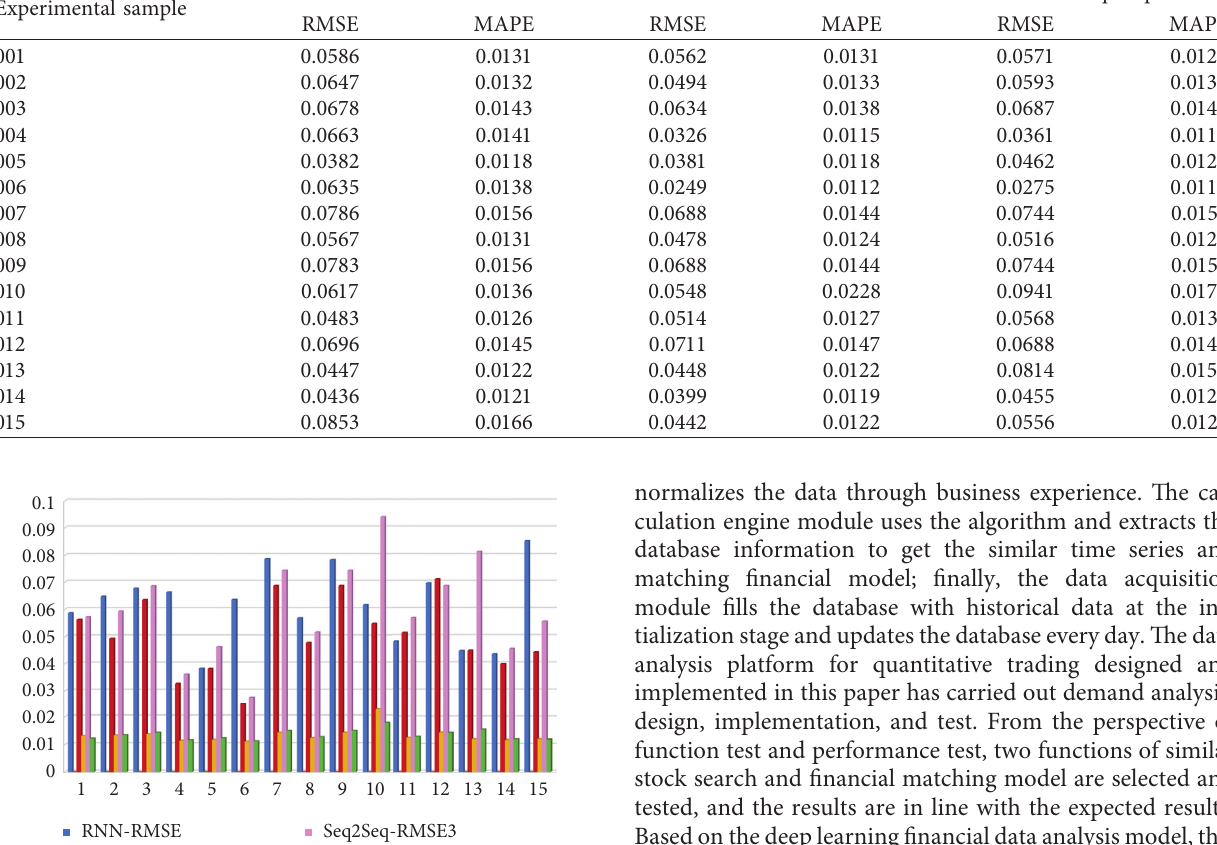
Experimental sample